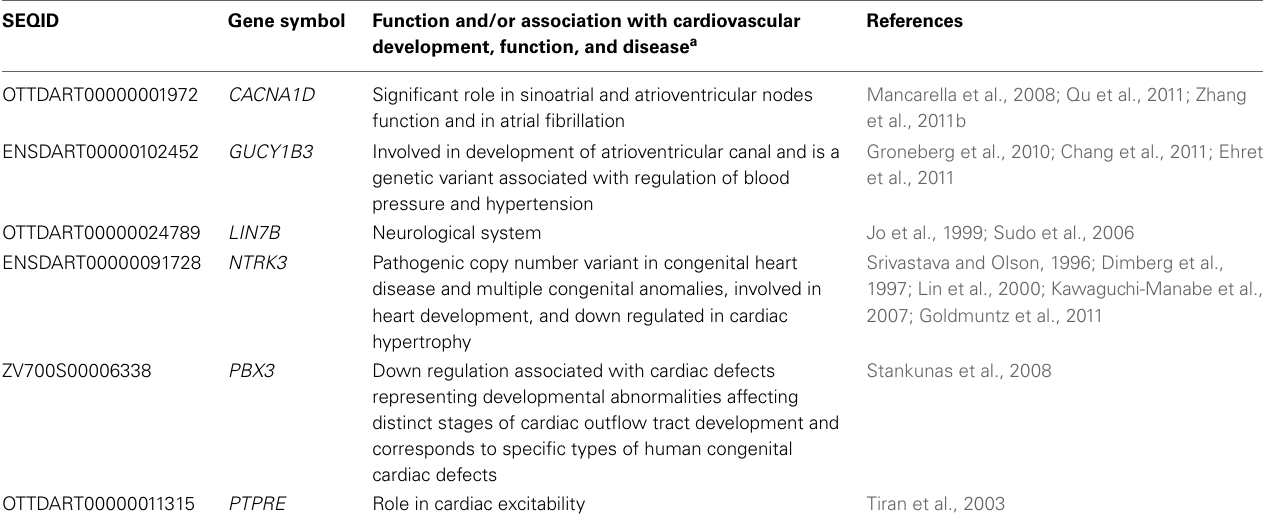
Table 3 | Genes targeted for qPCR and their associated functions.